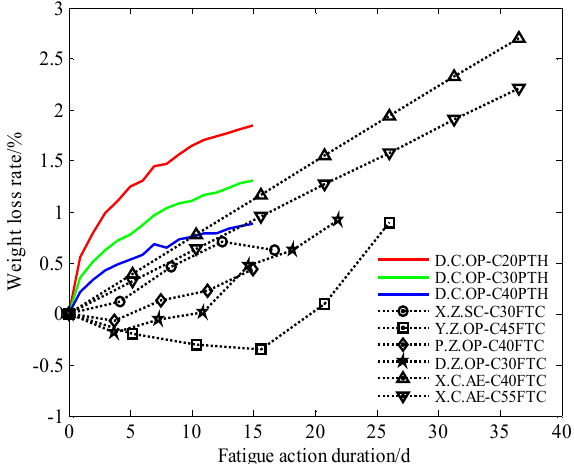
Figure 4. Weight loss rate of concrete under di ff erent fatigue actions.